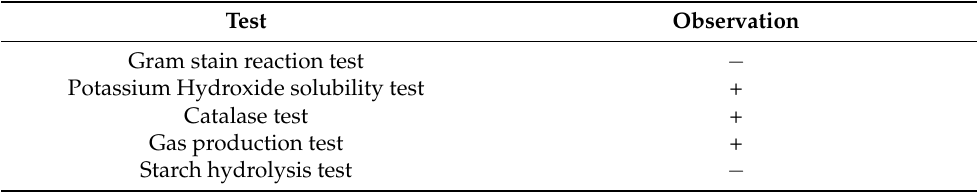
Table 1. Gram staining and biochemical reaction tests for the isolated R. solanacearum . Test Observation Gram stain reaction test − Potassium Hydroxide solubility test + Catalase test + Gas production test + Starch hydrolysis test